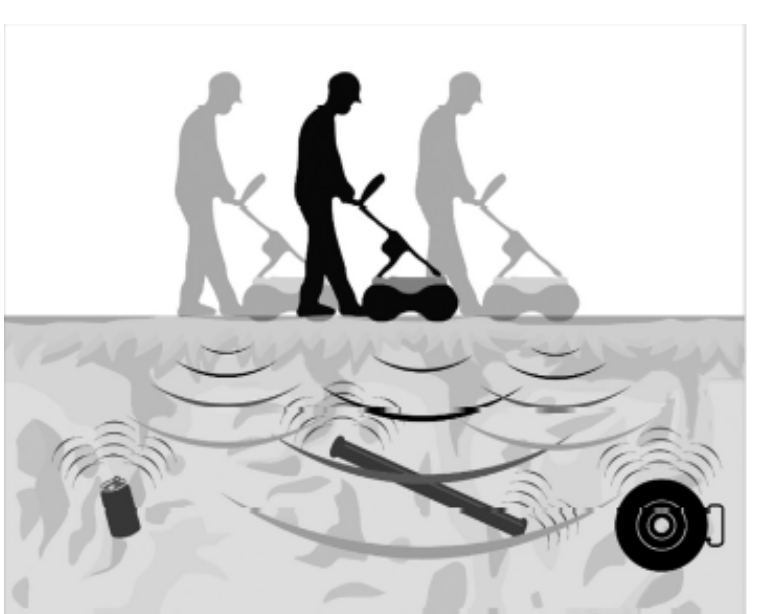
Figure 12. GPR survey conducted using a human-operated device. Reprinted under Creative Commons CC BY-NC license [64].